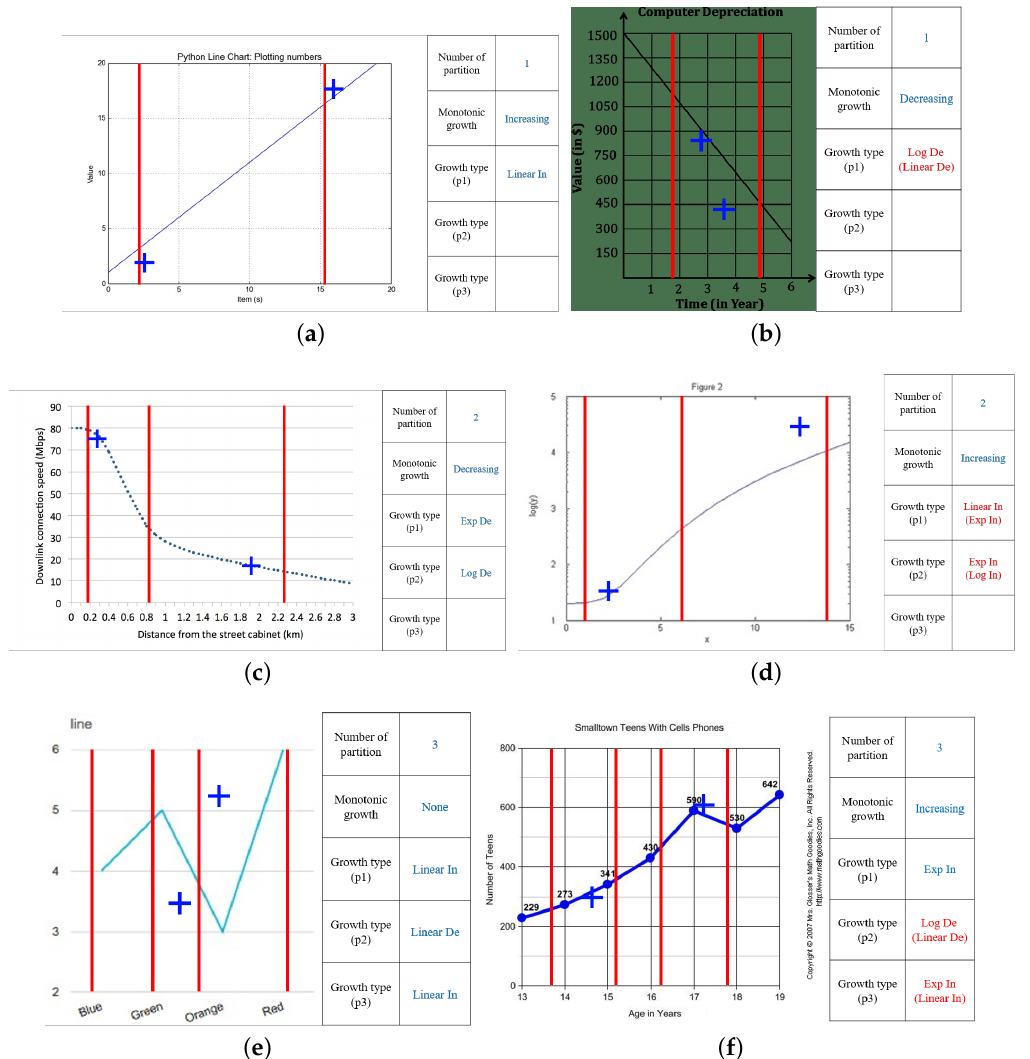
Figure 9. Example of detailed results with the human-labeled dataset. Blue, correct prediction; red, wrong prediction; In, increase; De, decrease; blue cross, minimum and maximum point; red line, partition boundary. These test data consist of one line chart, so superiority evaluation was